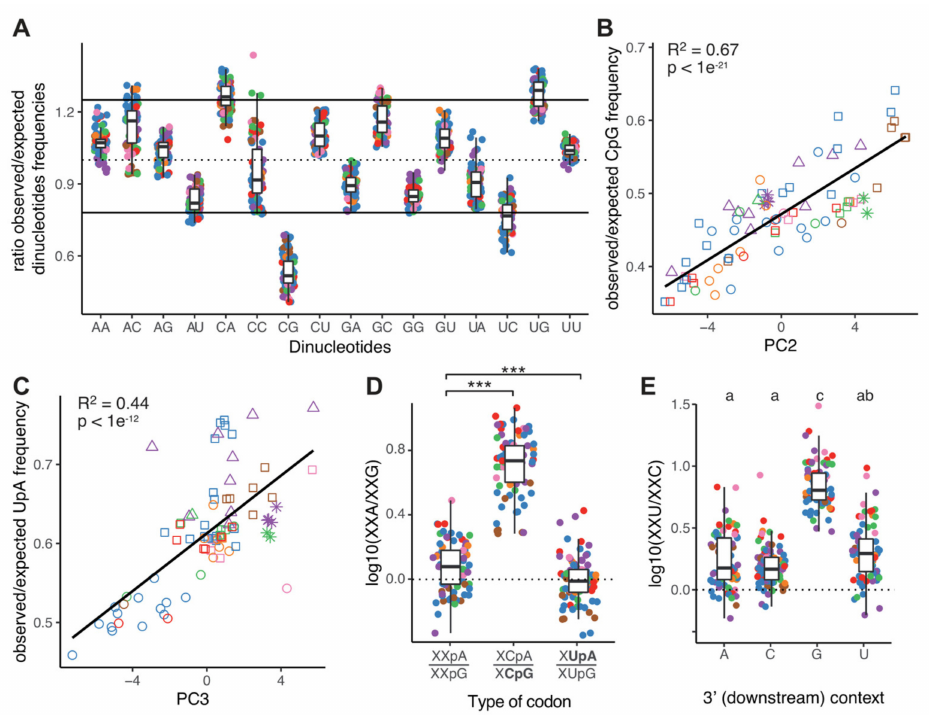
Figure 3. Dinucleotide Bias in Coronavirinae. ( A ) Box (median, 1st and 3rd quartiles) and whiskers (95% CI) plot for the ratio of the observed over the expected frequency (dinucleotide relative abun- dance) for all 16 dinucleotides in the coding sequences of 82 CoVs. Continuous lines indicate the thresholds for considering over/under representation of the corresponding dinucleotide over the expected values given the frequencies of the individual nucleotides. The threshold values at 0.78 and 1.25 have been phenomenologically determined following [57]. Colors correspond to the different host taxonomy orders. ( B ) Linear regression between the projections of each individual viral genome on the second dimension of the synonymous codon usage Principal Component Analysis (Figure 1A) and the observed/expected frequency of the CpG dinucleotide. Shapes correspond to viral taxonomy genera and colors correspond to host taxonomy orders. ( C ) Linear regression between the projections of each individual viral genome on the third dimension of the synonymous codon usage Principal Component Analysis and the observed/expected frequency of the UpA dinucleotide. Shapes corre- spond to viral taxonomy genera and colors correspond to host taxonomy orders. ( D ) Box (median, 1st and 3rd quartiles) and whiskers (95% CI) plot for the ratio in synonymous codon frequency of A- over G-ending codons, calculated for codon families with multiplicity two lacking CpG and UpA dinucleotides (Gln, Lys and Glu, indicated as “XXpA/XXpG”, constituting the reference set for comparison), amino acids encoded by CpG-ending codons (Ser4, Pro, Thr, Ala, indicated as “XCpA/XCpG”), and amino acids encoded by UpA-ending codons (Leu2, Leu4, Val, indicated as “XUpA/XUpG”). Colors correspond to the different host taxonomy orders. Differences within amino categories were assessed by a paired Wilcoxon signed rank test (Bonferroni correction, code for p -value: *** <0.001). ( E ) Box (median, 1st and 3rd quartiles) and whiskers (95% CI) plot for the ratio in synonymous codon frequency in U- over C-ending codons, calculated for codon families with multiplicity four, and stratified by the nature of the 3 (cid:48) downstream nucleotide. Differences depending on 3 (cid:48) base context were assessed by a paired Wilcoxon signed rank test (Bonferroni correction) and summarized among sets of groups statistically different one from another. Colors correspond to the different host taxonomy